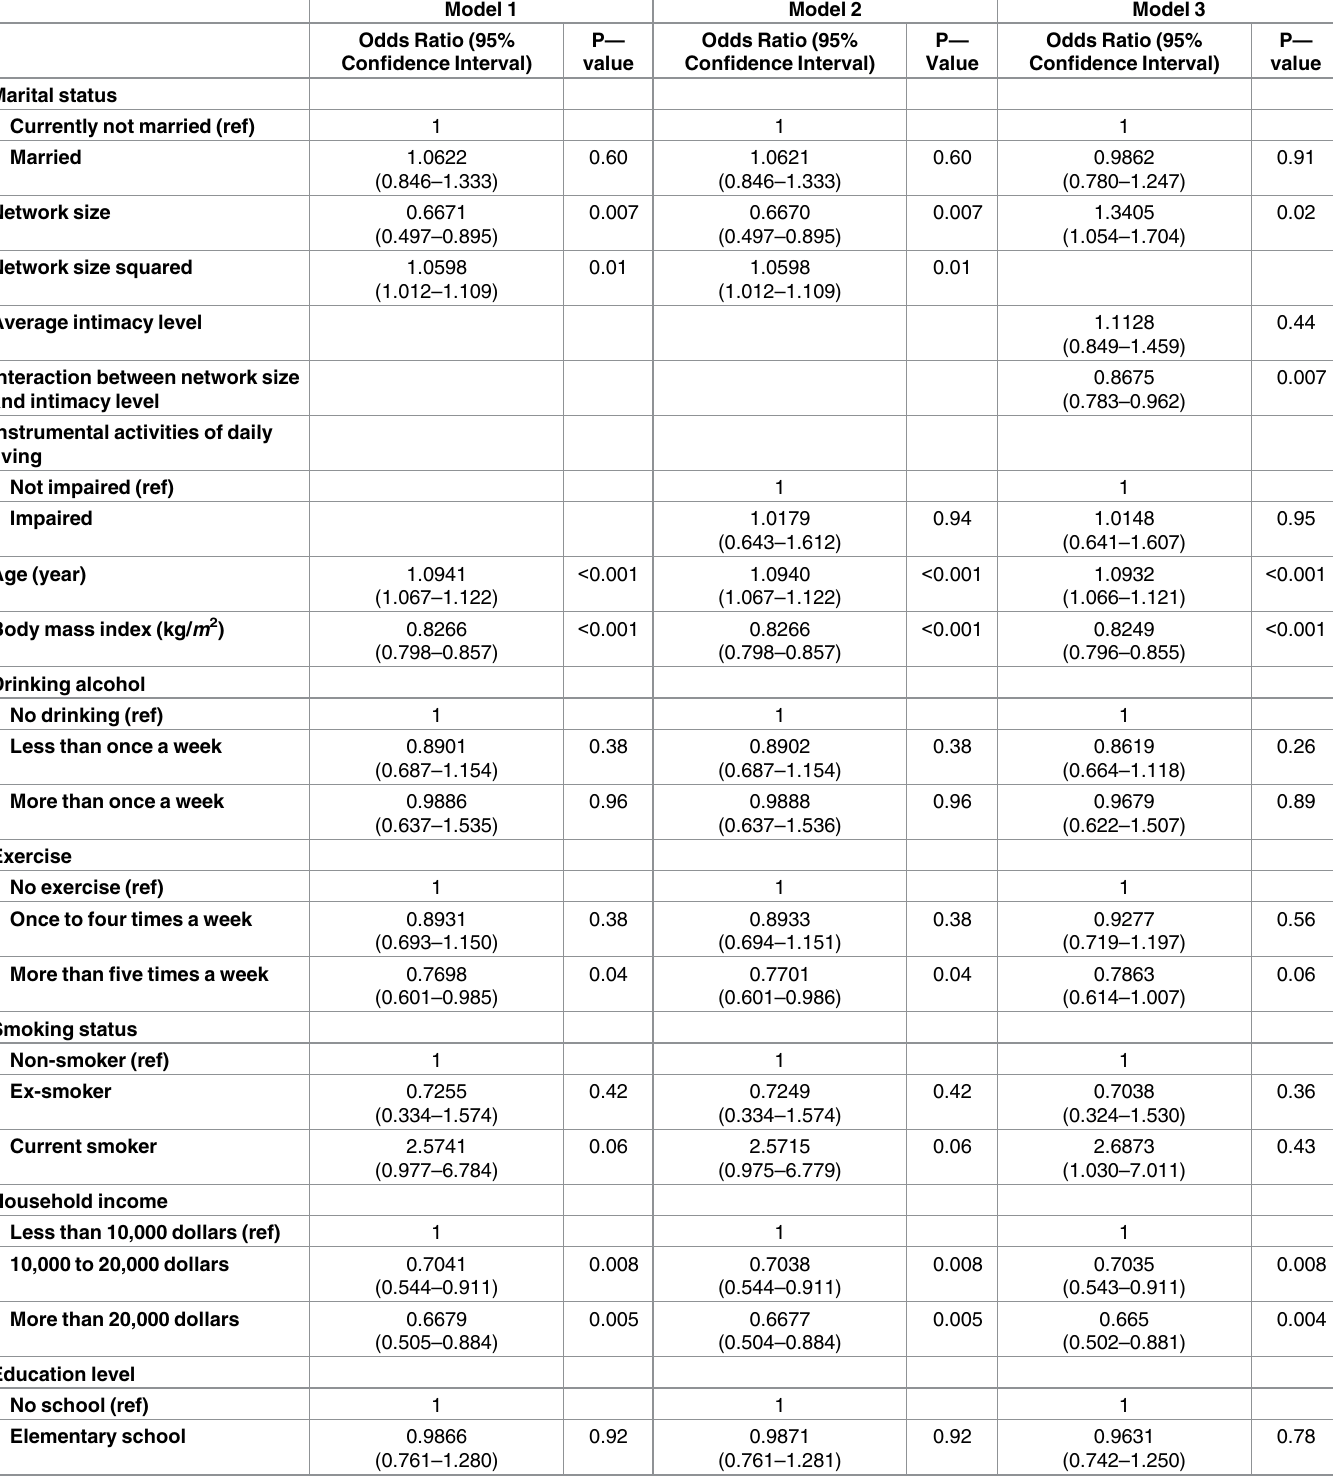
Table 2. The multiple logistic regression model presenting the curvilinear association between social support network size and osteoporosis (Defined by BMD (cid:21) 2.5 standard deviation from the mean for young